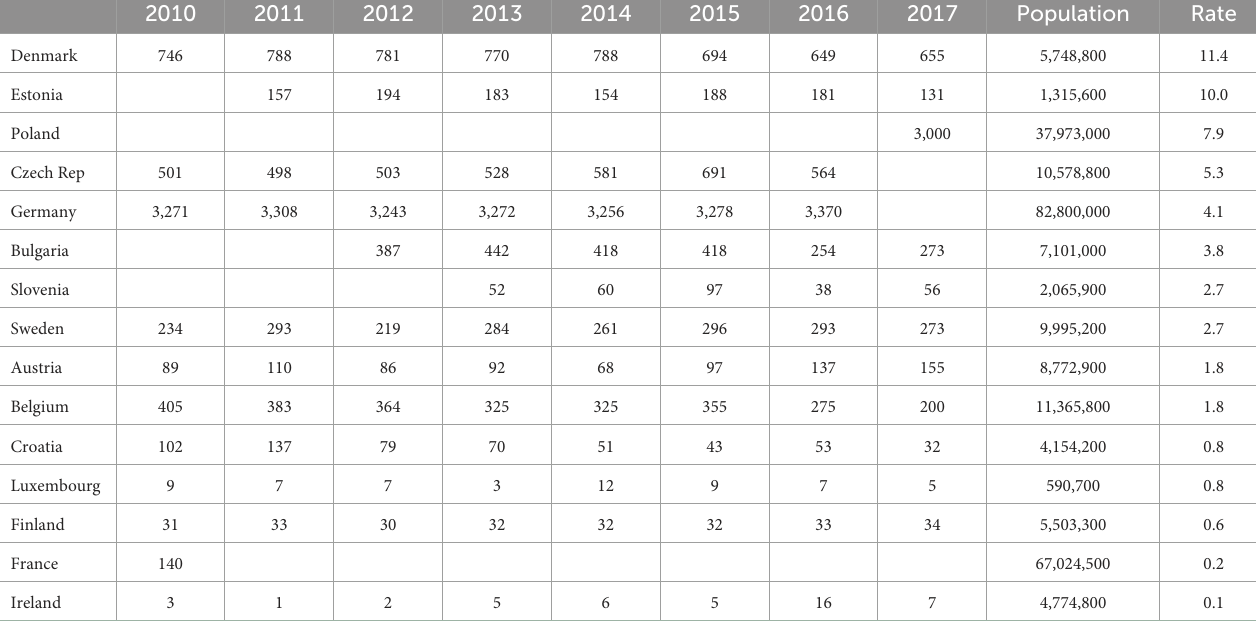
TABLE 4 Annual number of verdicts on persons not guilty for reason of insanity from 2010 to 2017 as an estimate for the incidence of mentally ill offenders in European Union Member